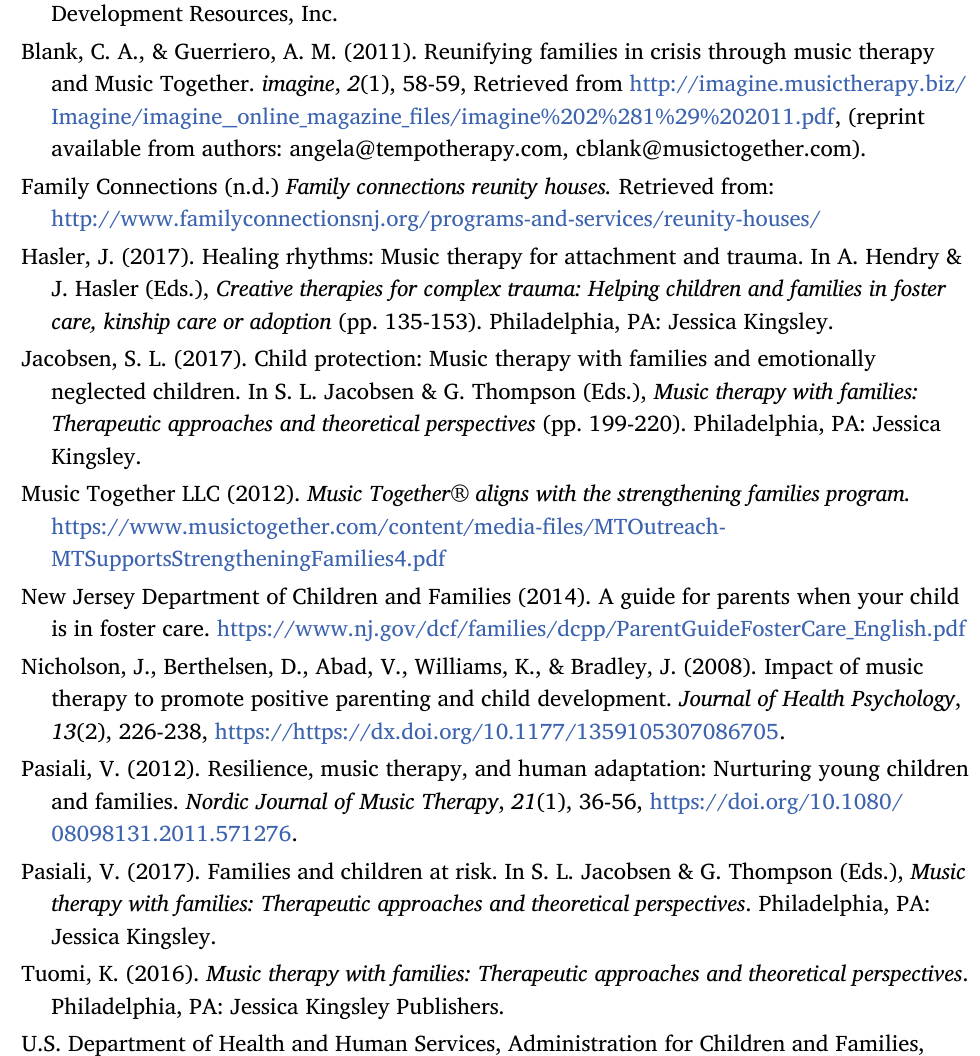
Table: www.cwla.org 6 Numbers of Children Exiting Foster Care by State FY 2005– FY 2014. Retrieved from